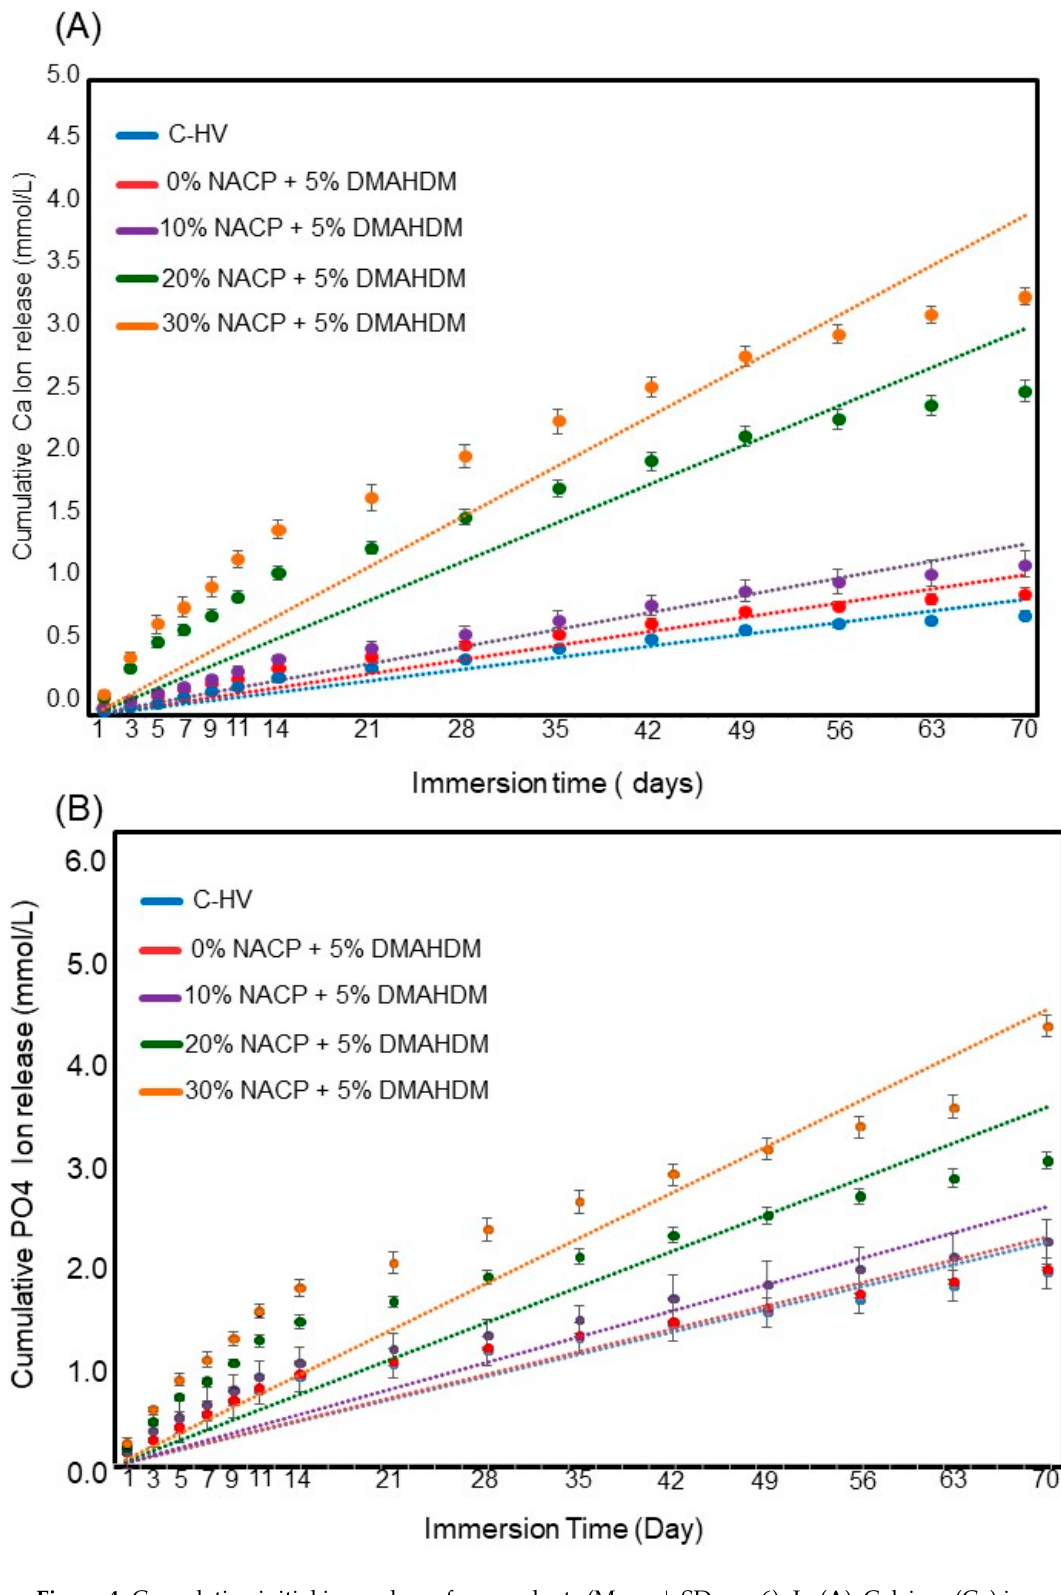
Figure 4. Cumulative initial ions release from sealants (Mean ± SD; n = 6). In ( A ), Calcium (Ca) ion and in ( B ) Phosphate ions. The dots for each group show the exact data and the dotted line is its approximate linear trend for each formulation.